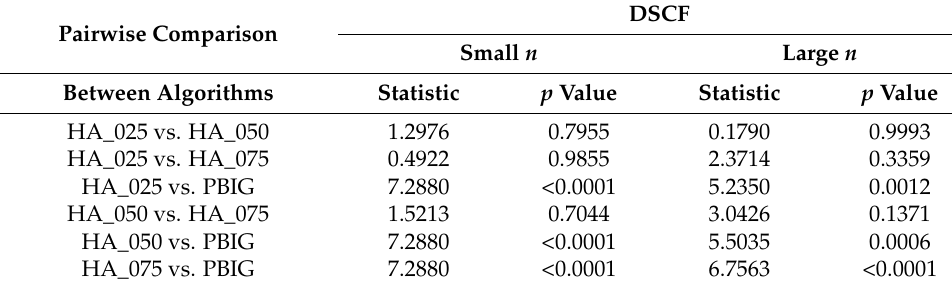
Table 6. DSCF pairwise